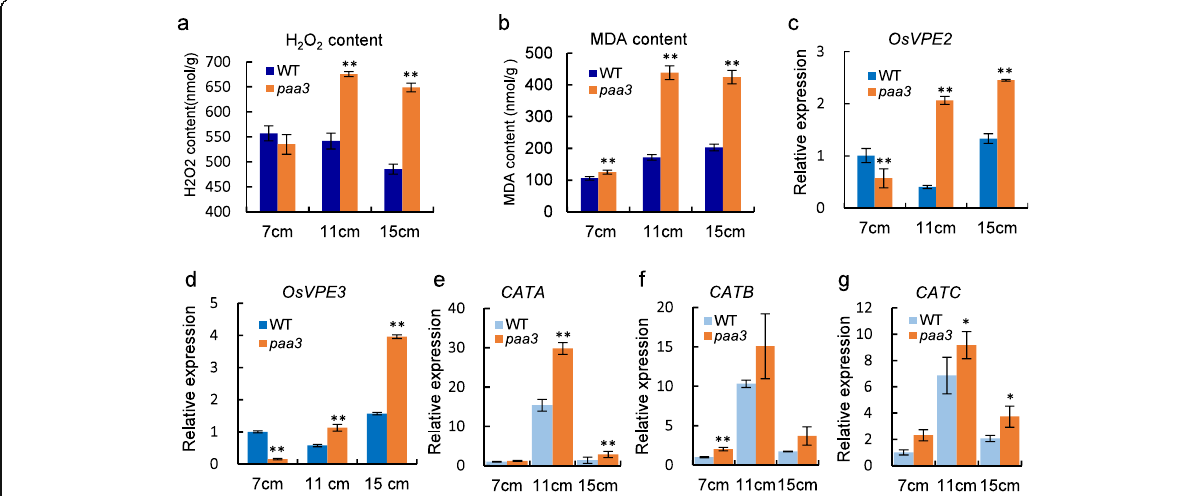
Fig. 6 Cell death-related Events are induced in paa3. a : Measurement of H 2 O 2 content in panicles of the 7, 11, and 15 cm stages in WT and paa3 . b : Measurement of MDA content in panicles of the 7, 11, and 15 cm stages in WT and paa3 , showing overaccumulation of ROS during late development stages in paa3 . c : Expression level of OsVPE2 in WT and paa3 panicles at the 7, 11, and 15 cm stages. d : Expression levels of OsVPE2 and OsVPE3 in WT and paa3 panicles at the 7, 11, and 15 cm stages, which showed PCD from the stage of 11 cm. e – g : Relative expression of CATA , CATB , and CATC isozymes. (rice ACTIN was used as the internal control). * indicates p < 0.05; ** indicates p < 0.01 (Student ’ s